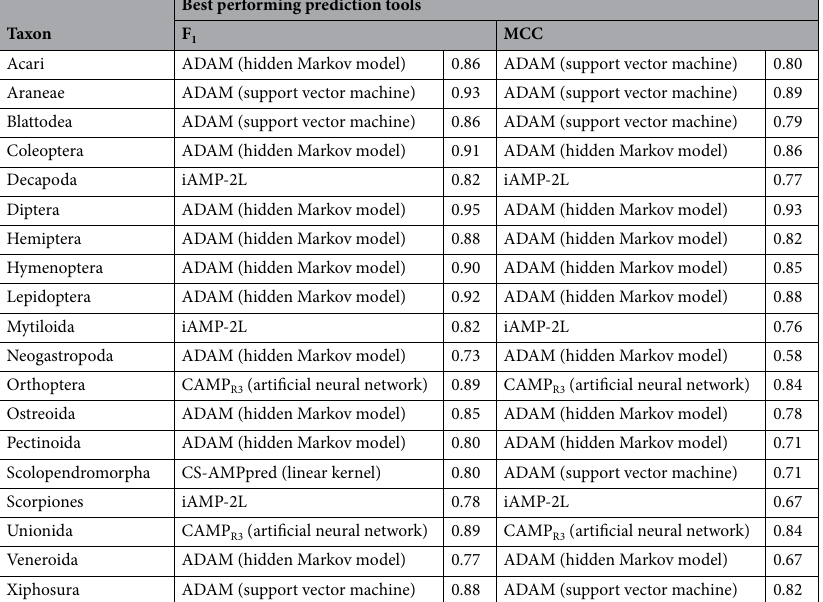
Table 1. Best preforming prediction tools for given taxa based on F 1 and Matthew’s correlation coefficient (MCC).